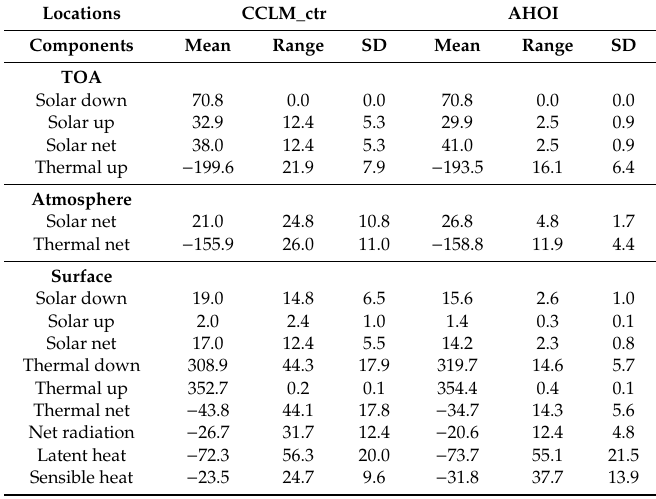
Table 2. Simulated energy balance components ((W / m 2 ), negative downward) averaged over NwgSea from stand-alone CCLM (CCLM_ctr) and coupled CPL ensembles at the top of atmosphere TOA, atmosphere and surface on 28 October